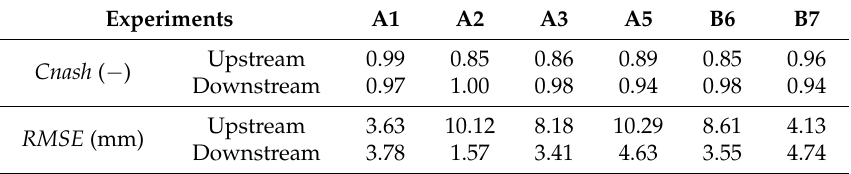
Table 5. Values of the performance criteria calculated during the verification step of the fitting process. CNASH is the Nash criterion. RMSE is the Root Mean Square Error between simulated and measured data.